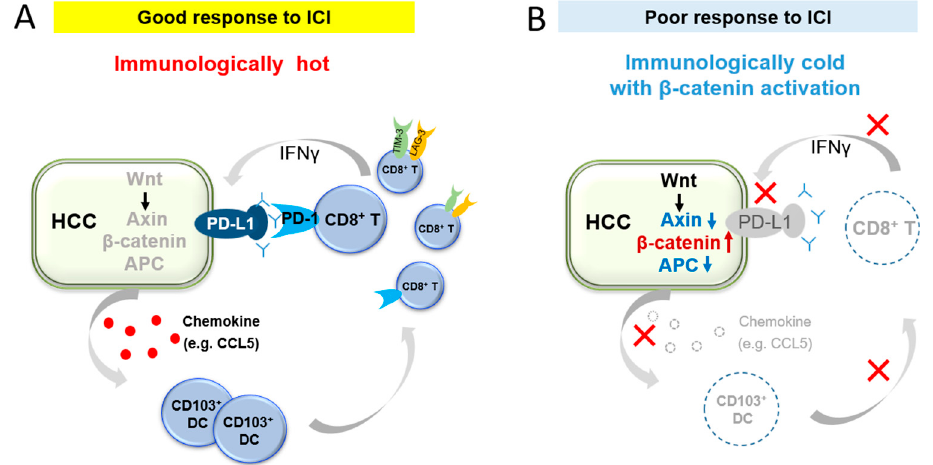
Figure 2. Schematic representing a hypothesis for β -catenin activation and immune response in the tumor microenvironment. ( A ). Hepatocellular carcinoma (HCC) cells produce chemokines (e.g., CCL5), which results in CD103+ dendritic cell recruitment and antigen presentation. As a result, T cell priming and activation occurs; then, CD8+ cells migrate to tumor cells. CD8+ cells target tumor cells and release IFN γ . IFN γ induces PD-L1 expression. Therefore, ICIs targeting the PD-1/PD-L1 axis function well in this tumor microenvironment. ( B ). HCC with β -catenin activation causes a decrease in certain cytokines (e.g., CCL5), which results in the inhibition of CD103+ dendritic cell recruitment. This inhibits T cell activation, forming a tumor microenvironment with poor CD8+ cell infiltration. Therefore, induction in PD-L1 expression is reduced due to reduced IFN γ secretion. Therefore, this tumor microenvironment is expected to be poorly responsive to ICIs that target the PD-1/PD-L1 axis.